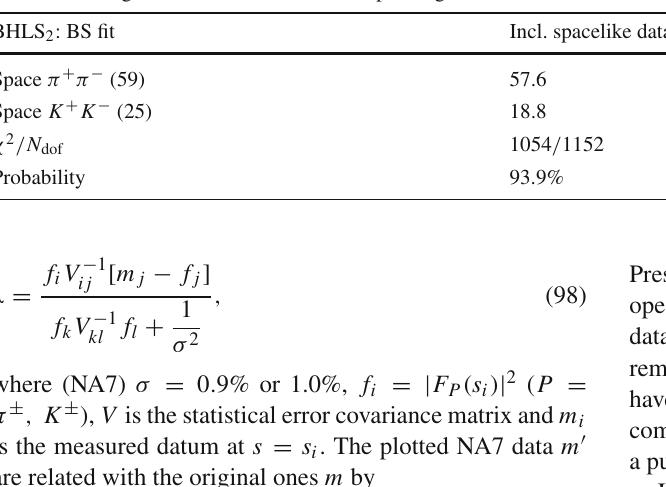
excluding all spacelike data. Global fit information is displayed in the last lines. The numbers of fitted data points in each channel are